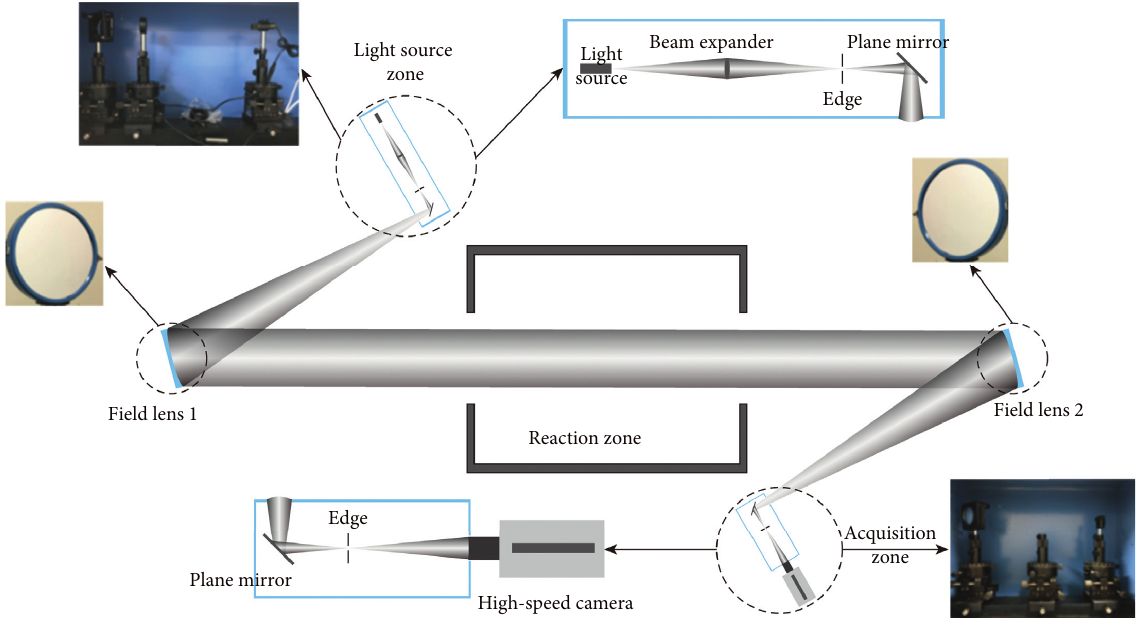
Figure 1: Schematic of the high-speed schlieren system.